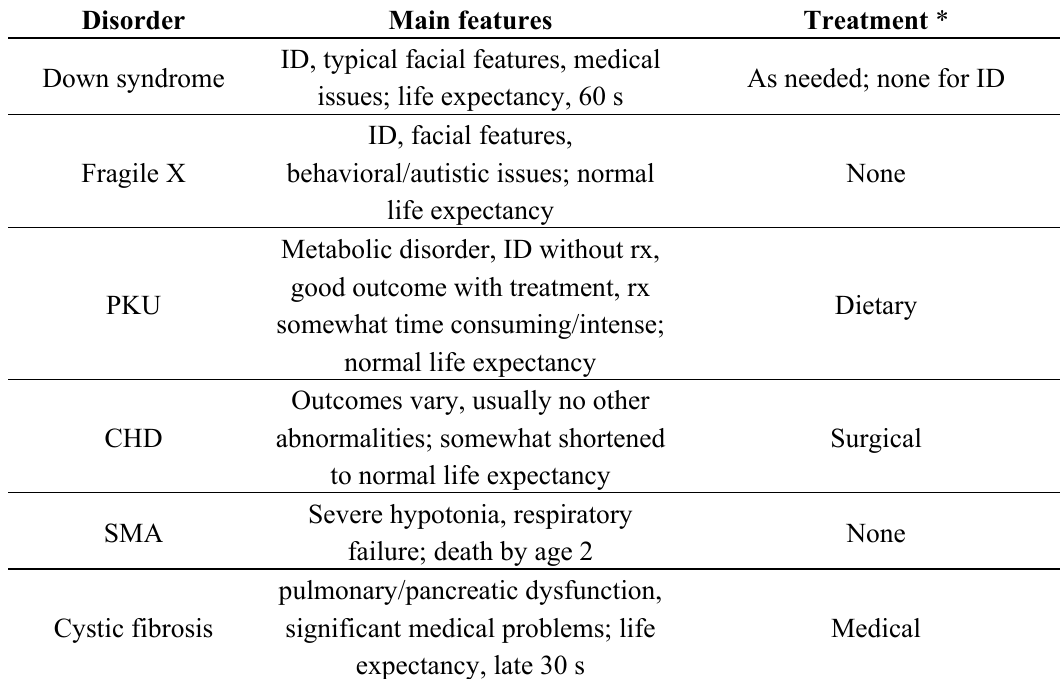
Table 1. Disorders and key characteristics presented to